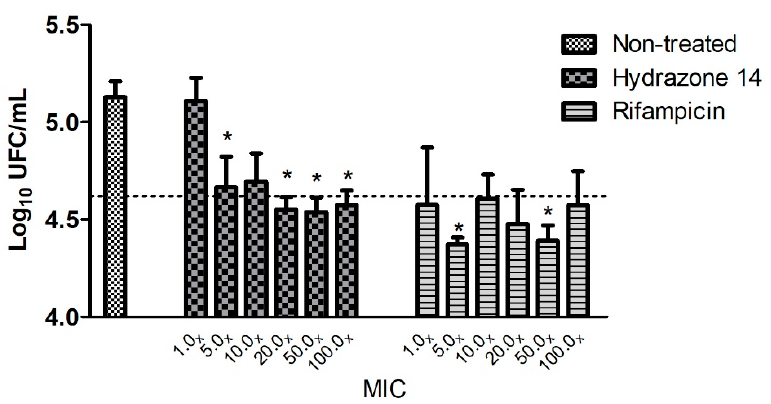
Figure 2. Intramacrophagic activity of hydrazone 14 and rifampicin at different MICs after 3 days of exposure. The results are presented as the mean and standard deviation of three independent experiments. The line represents an inhibition of 1 log 10 CFU/mL compared to non-treated control. * p < 0.05, statistically significant differences found compared to the non-treated group.